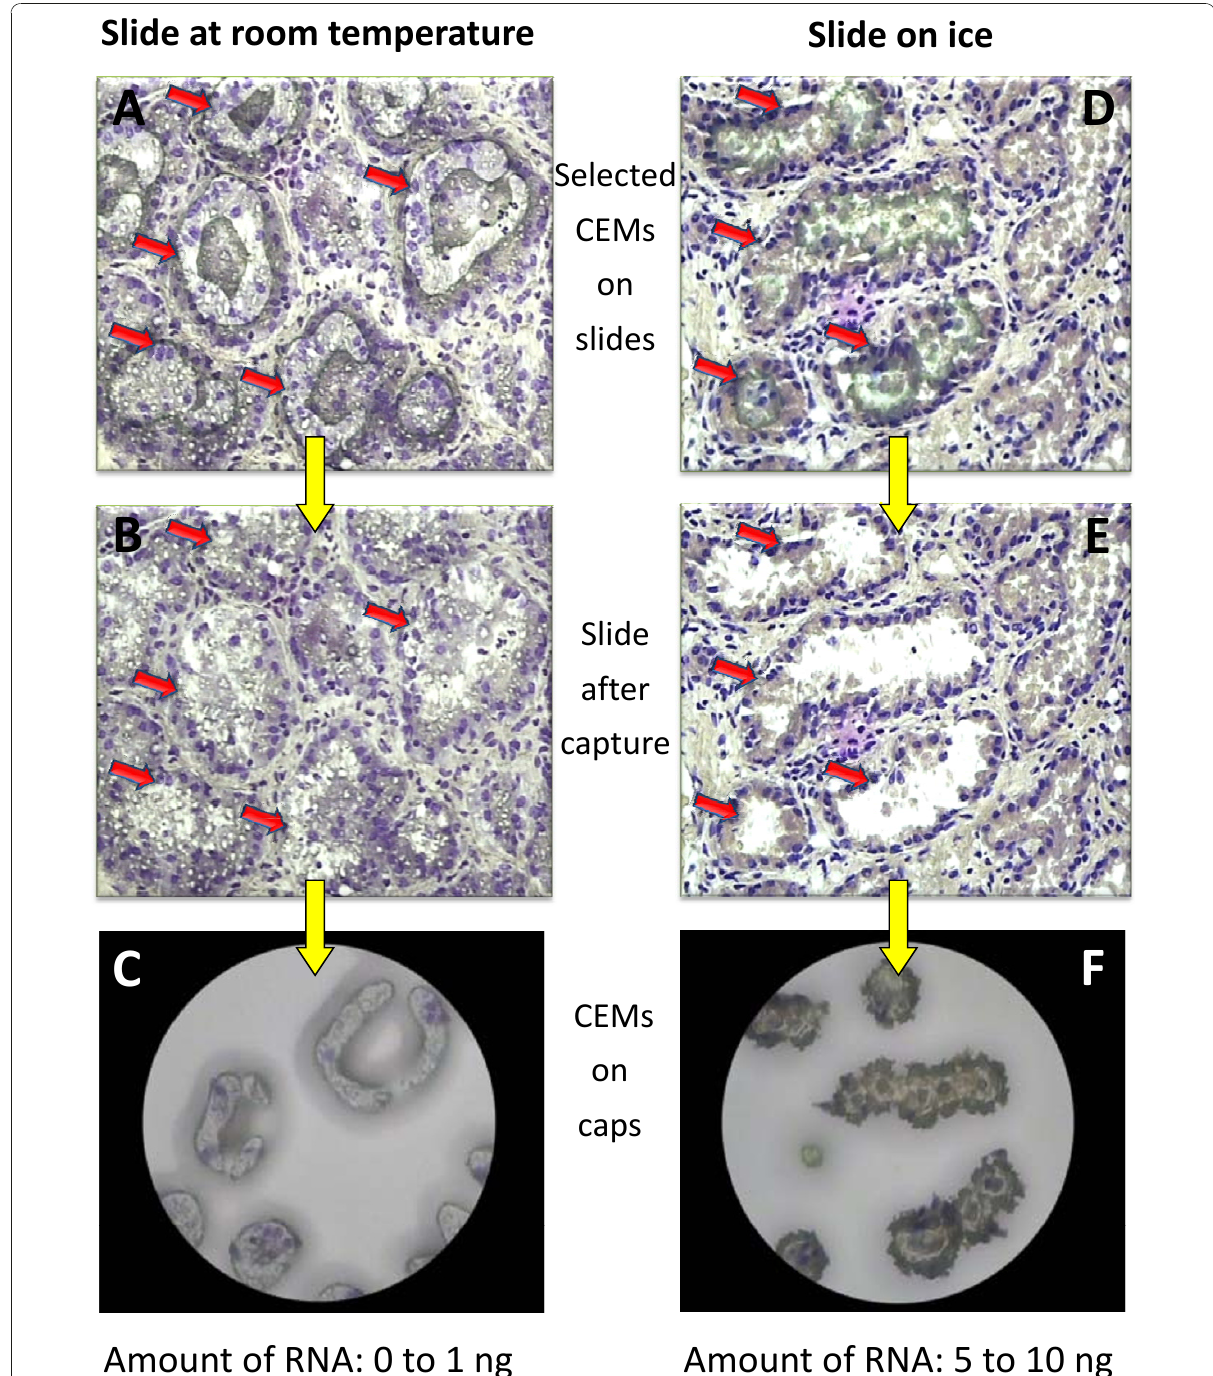
Figure 2 Impact of glass slide temperature on cell transfer efficiency and RNA extraction yield . Frozen tissues cut at 8 μ m and transferred on glass slides that have been placed at room temperature (A) or chilled and kept at 4°C, before transfer (D). As evidenced by the number of cells captured (C and F) and the RNA yield, given under each cap (C and F) the efficiency of capture was very low for the slides placed at room temperature. A/D: Cresyl violet® stained slides before LCM; red arrows indicate the thermoplastic film stuck on epithelial cells to be captured. B/E: mammary tissue section remaining on the glass slide after LCM. C/F: microdissected mammary epithelial cells transferred on the LCM cap. Magnification: